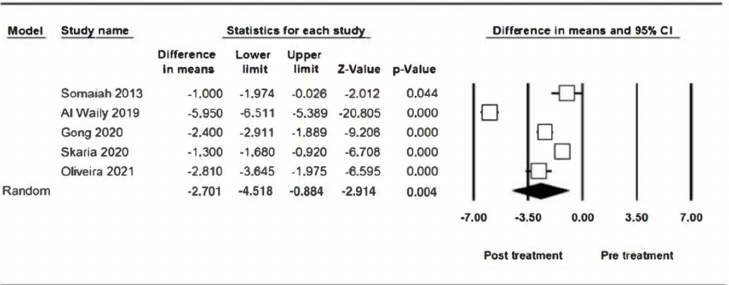
Figure 3. Meta-regression analysis units of BTX-A/gummy smile reduction at two weeks.